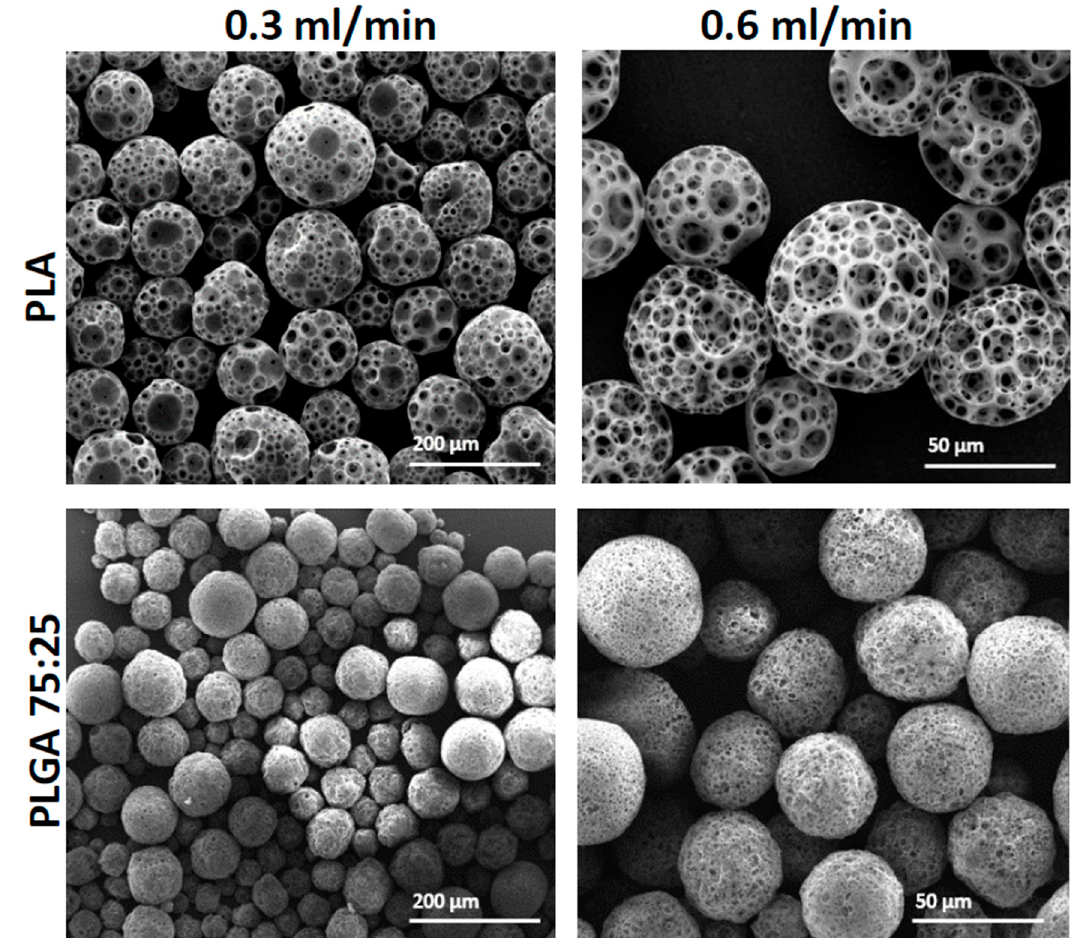
Figure 6. SEM images of porous polymeric MPs fabricated with increased continuous phase flow by a microfluidic droplet generation device. PLA and PLGA 75:25 MPs were fabricated with either 0.3 mL/min or 0.6 mL/min 0.5% PVA continuous phase. The primary emulsion (W 1 /O) flow rate was kept constant at 0.05 mL/min.